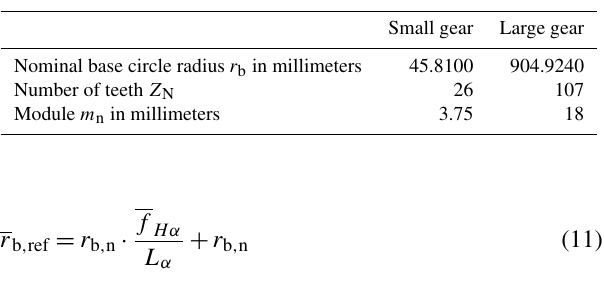
Table 2. Gear parameters of a small and large gear for the deter- mination of the mean base circle radius by means of Monte Carlo